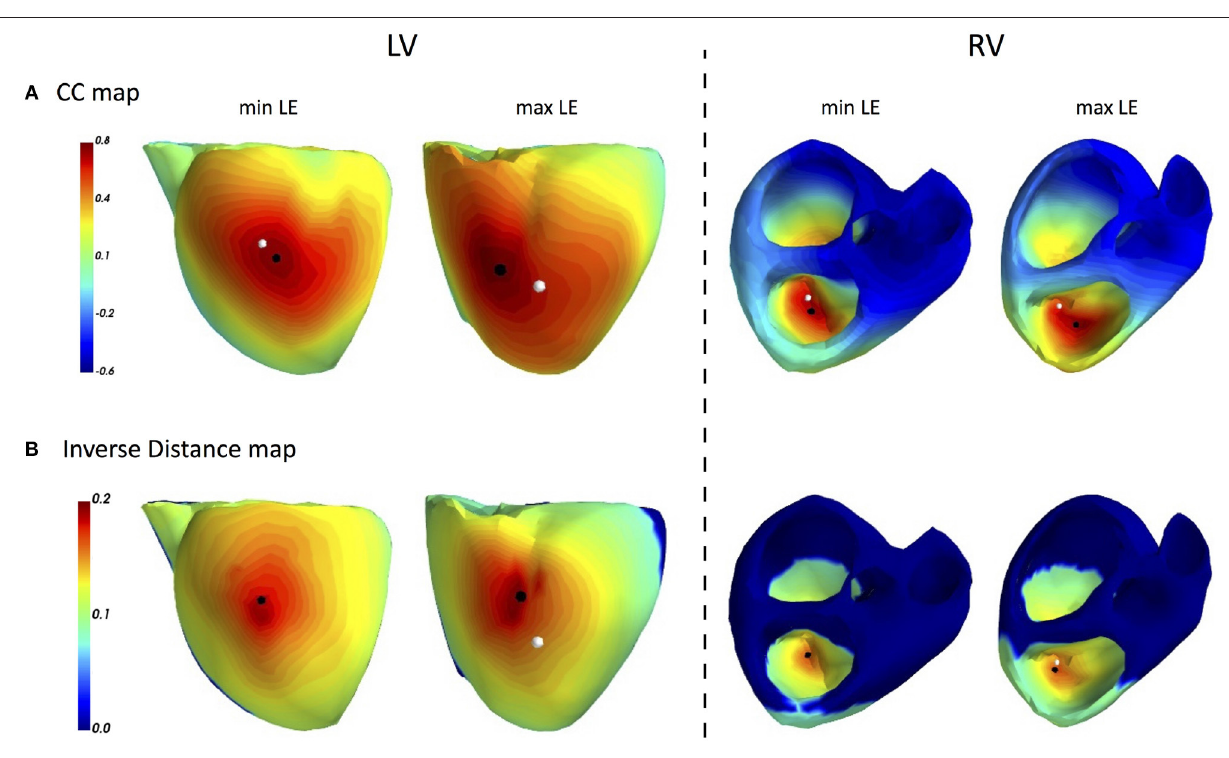
FIGURE 7 | ECGI results for single pacings in CRT patients: FRA based CC maps (A) and FRA-DTW based inverse distance maps (B) . The white dot marks a pacemaker lead position projected on the cardiac surface, while the black point labels the reconstructed excitation origin. In the cases of minimal LEs for both LV and RV (first and third columns), the FRA-DTW method localized the onset at the same mesh node as the pacemaker lead. The accuracy of FRA was 8 and 16mm, respectively. The cases, featuring maximal LEs for FRA-DTW, resulted in 16 and 16mm for